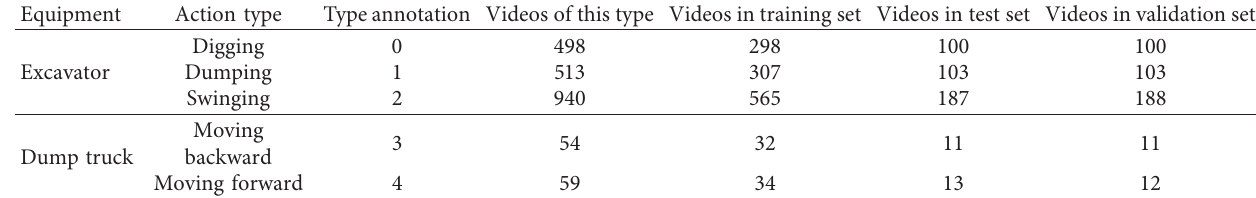
Figure 2: Camera setup used for recording the movement of construction equipment. Table 2: Dataset composition and action